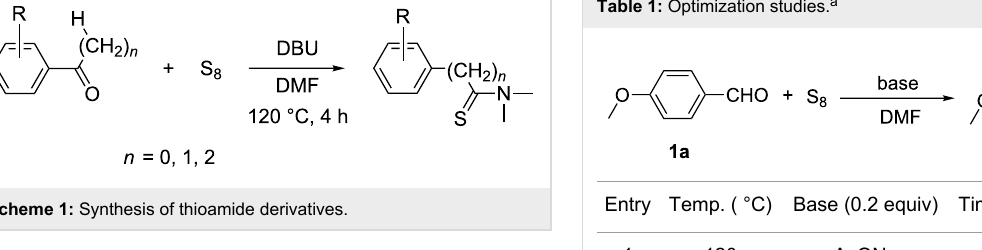
Table 1: Optimization studies.